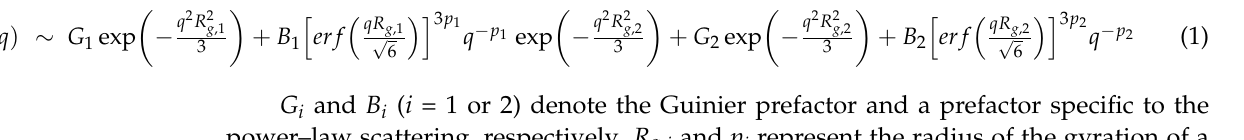
Figure 5. WAXS ( a ) and SAXS ( b ) curves for GM gels during the FT process. At − 18 °C, very strong and sharp peaks appeared at 1.59, 1.69, and 1.80 Å − 1 , which were assigned to reflections from Ice Ih (hexagonal ice crystal) [30,31]. Afterward, as the temperature rose to temperatures above 0 °C, the crystalline peaks disappeared due to the fusion of ice crystals. In Figure 5b, we show the change in the SAXS curves during the FT process. The structures of GM gels during the FT process can be divided into three regions, (i) the structure before freezing, (ii) the structure during the freezing, and (iii) the structure